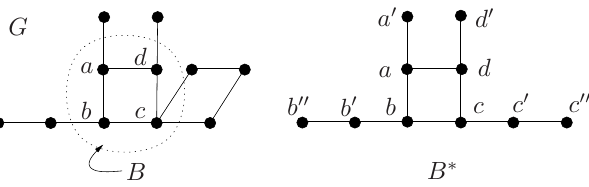
Fig. 2: A graph with block B and its corresponding B ∗ . ∂ 1 B = { a, d } , ∂ 2 B = { b, c } . We claim G is not a tolerance graph because { b (cid:48)(cid:48) , a (cid:48) , c (cid:48) } and { d (cid:48) , c (cid:48)(cid:48) , b (cid:48) } are asteroidal triples from different partite